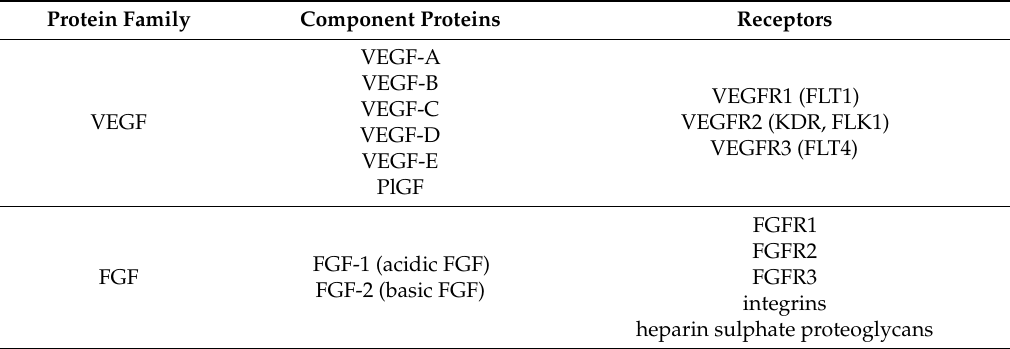
Table 1. The main angiogenic triggers involved in